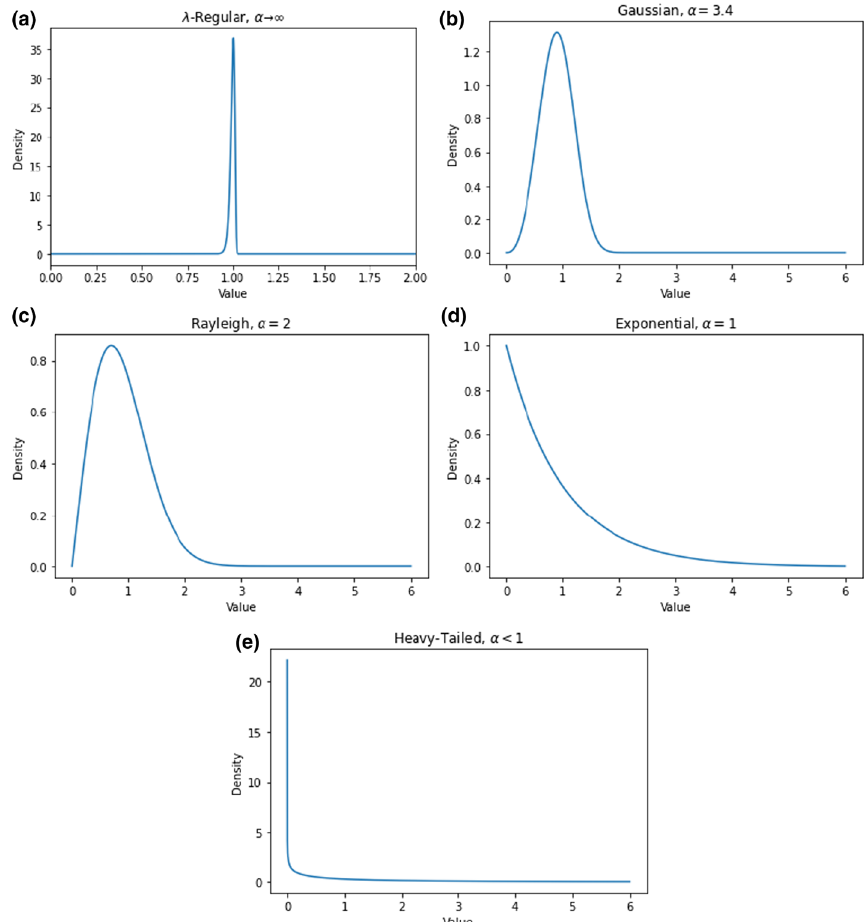
Fig. 1 Various cases of the probability density functions of the Weibull distribution generated by varying shape parameter α and scale parameter (cid:31) = 1 . a α → ∞ produces a nearly singular distribution at (cid:31) . b α = 3.4 produces a Gaussian‑like distribution. c α = 2 produces a Rayleigh distribution. d α = 1 produces an exponential distribution. e α < 1 produces a heavy‑tailed distribution